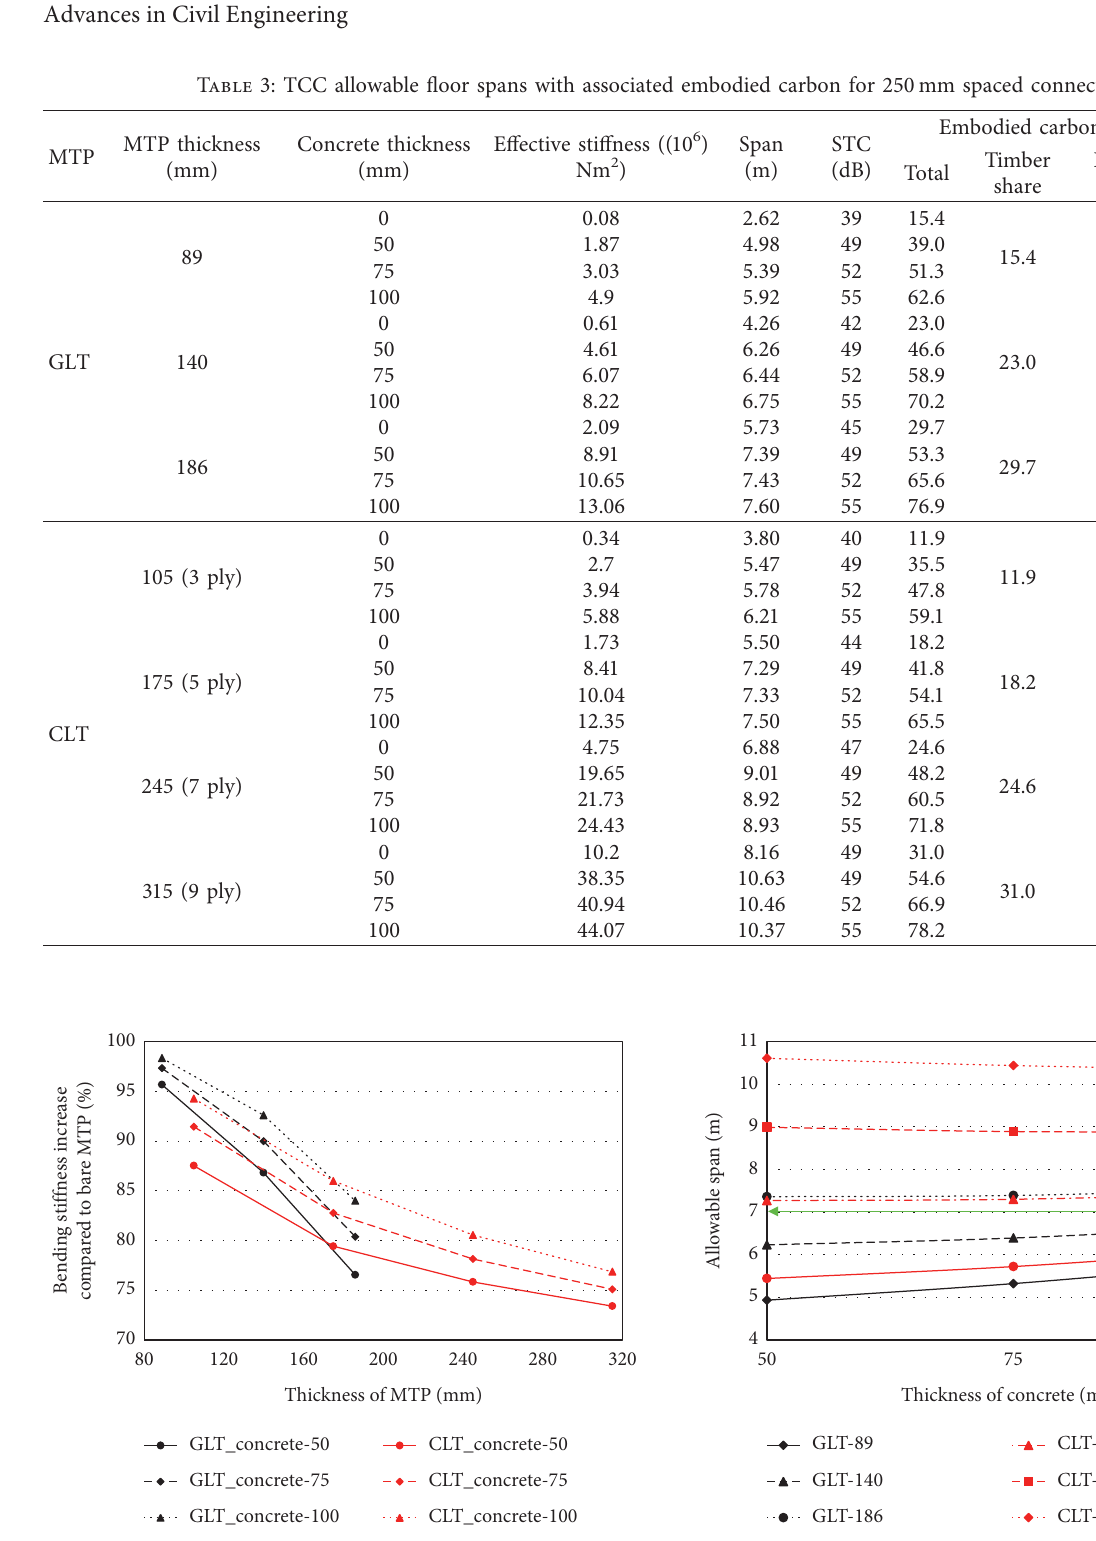
Figure 4: Effective bending stiffness increase compared to bare MTP versus thickness of MTP in TCC system. Figure 5: Allowable span versus thickness of concrete in TCC